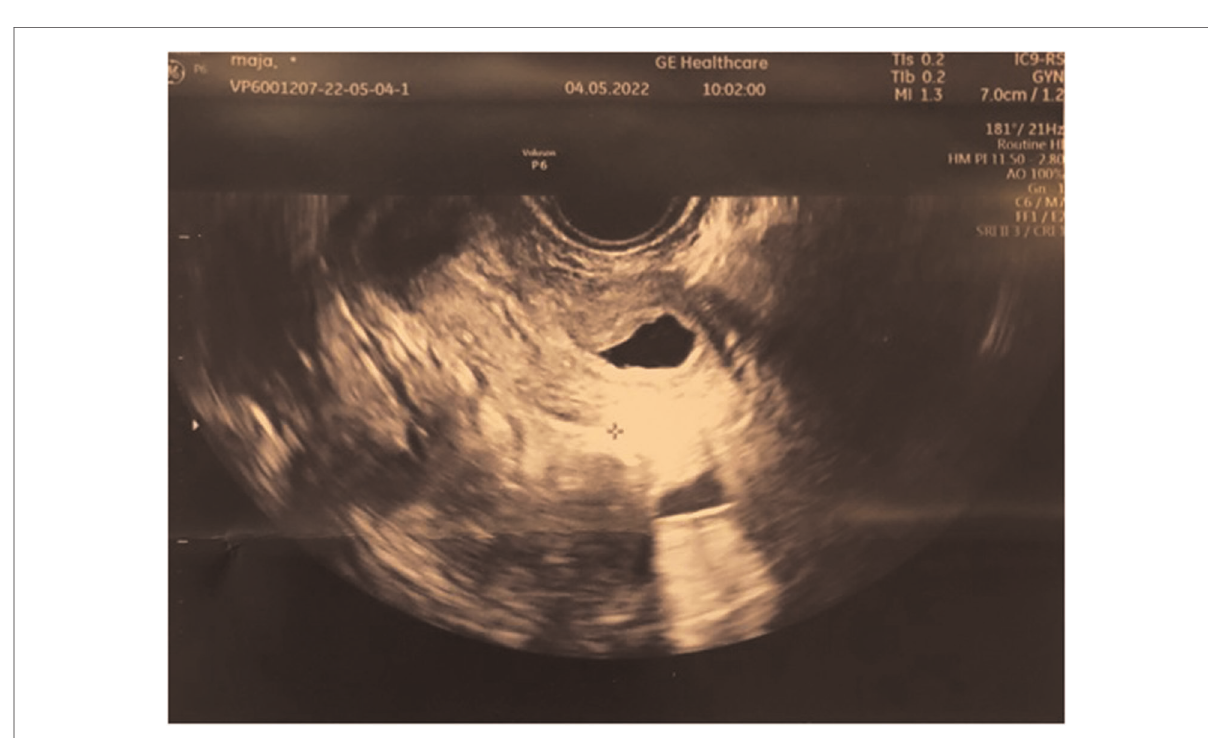
FIGURE 3 Intraoperative transvaginal sonography shows the resolution of